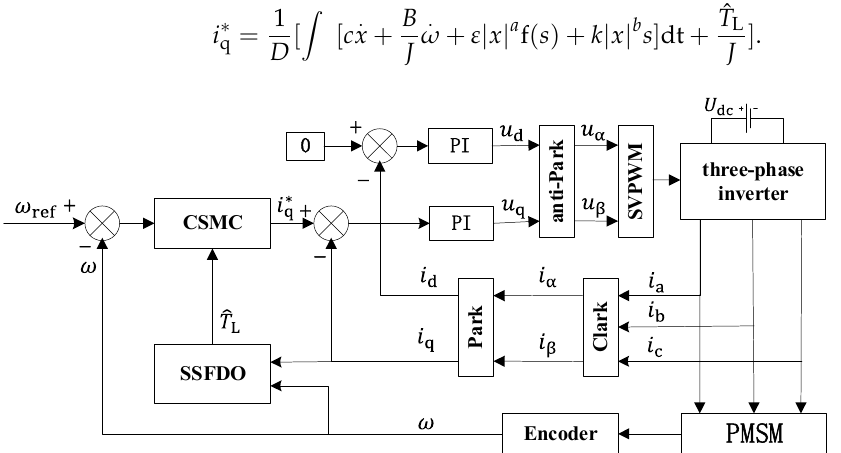
Figure 4. Block diagram of the compound sliding mode control (CSMC) system based on SSFDO.